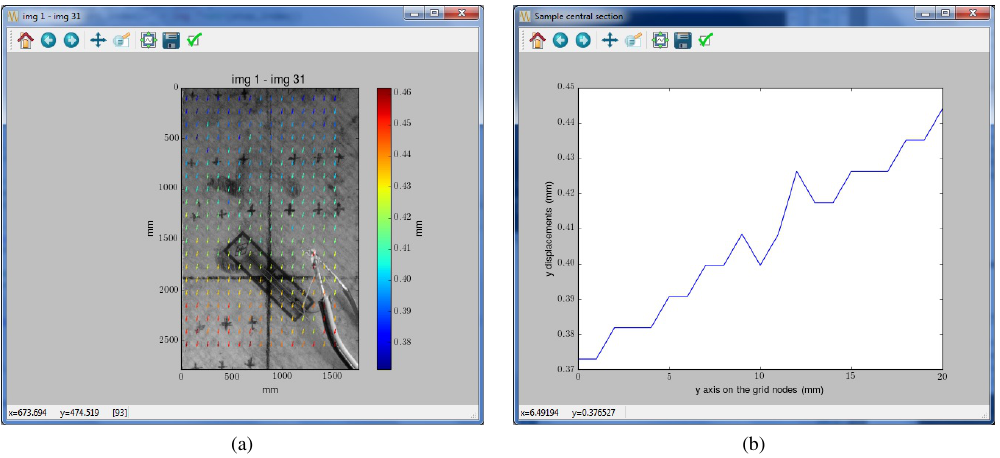
Figure 6: (a) Quiver plot of the computed displacements and (b) displacement plot of the sample central section. fixed on the opposite side with the same disposition. Finally, the last two strain gauges were located vertically on the lateral sides in order to measure the vertical